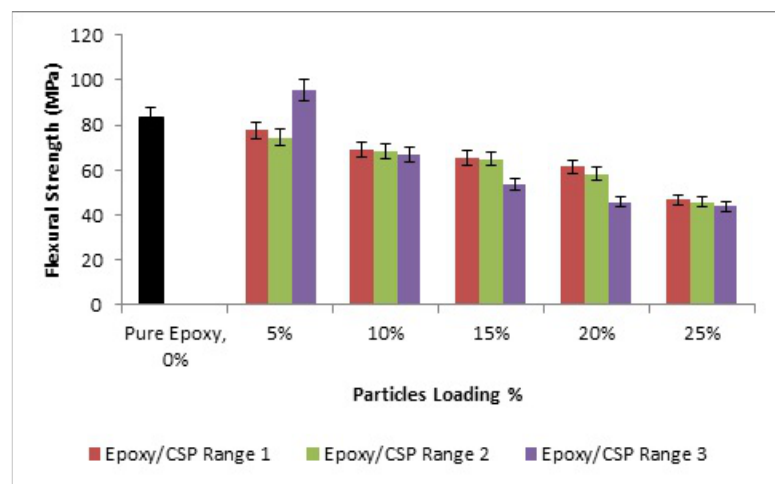
Figure 3: Flexural strength versus various particles